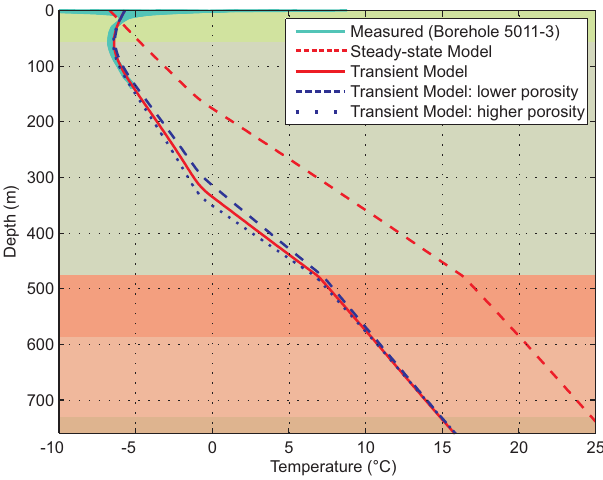
Fig. 13. Results from the model runs with varying porosity. The largest influence occurs in the temperature range where latent heat it is released or